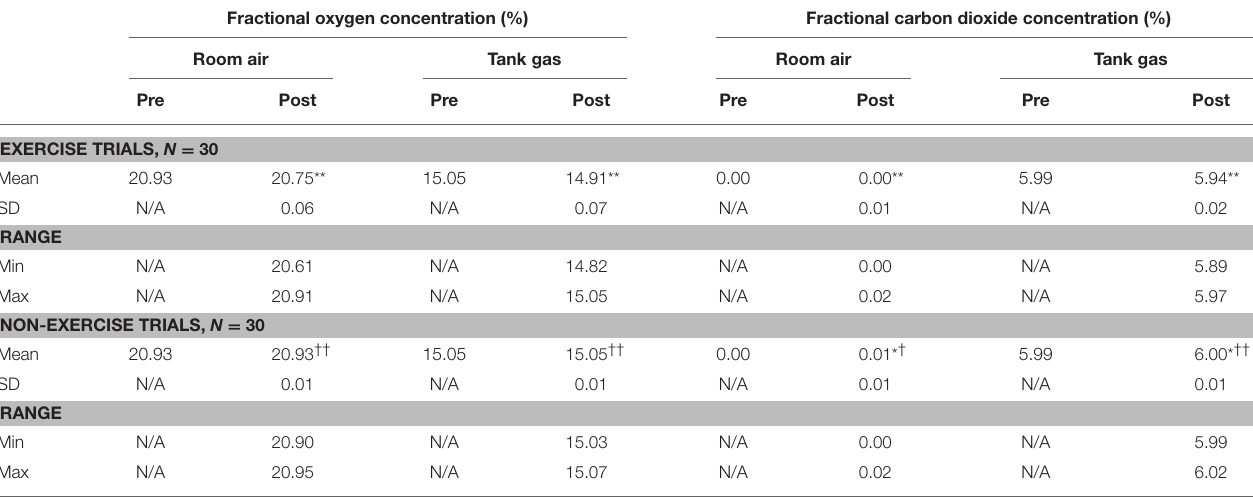
TABLE 2 | Calibration (pre-test) and verification (post-test) readings of the exercise and non-exercise